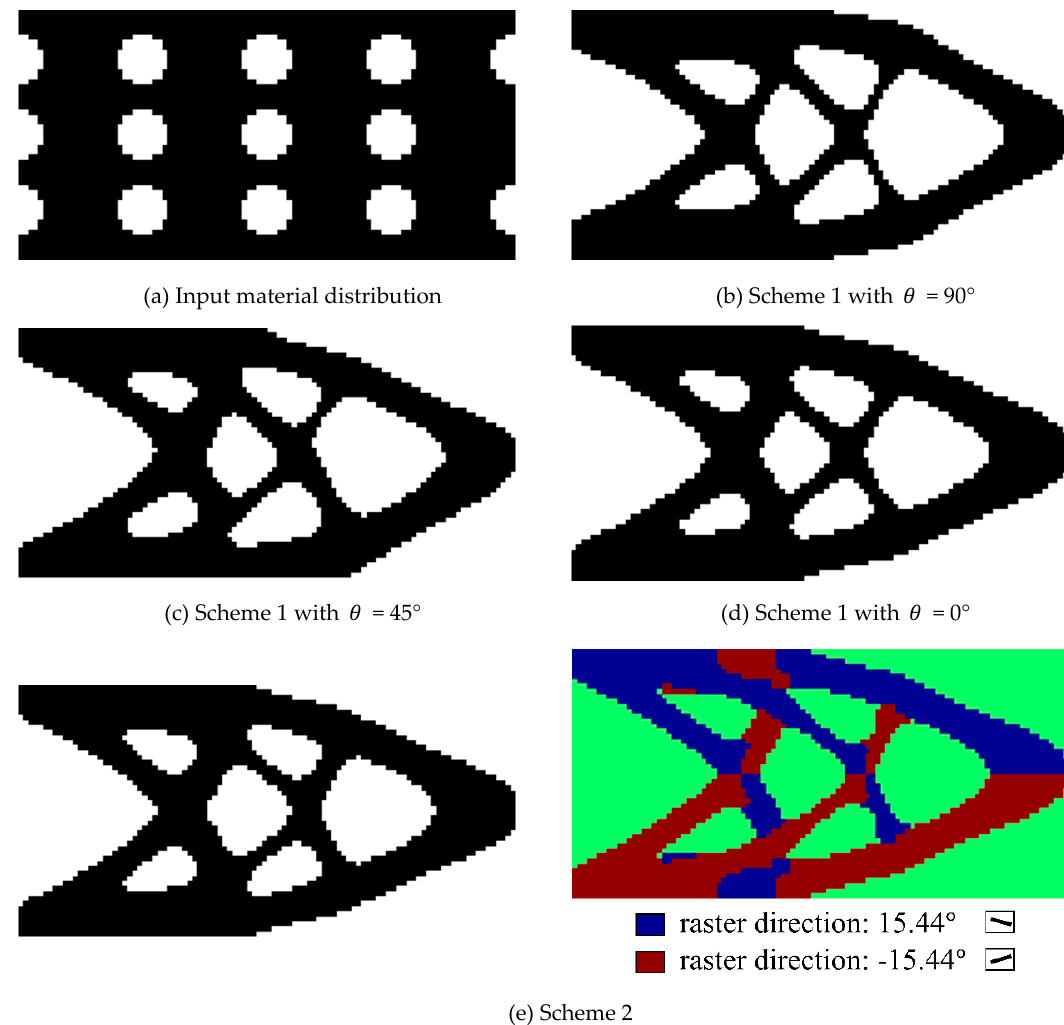
= 𝟏 , the red color 𝟏